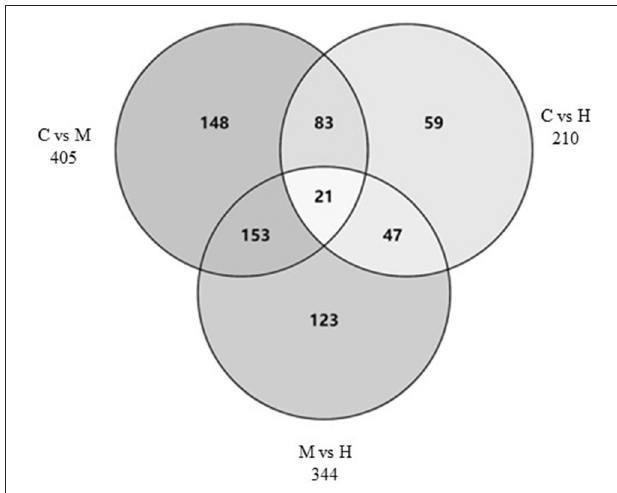
FIGURE 2 | Venn diagram of DEGs among three groups.